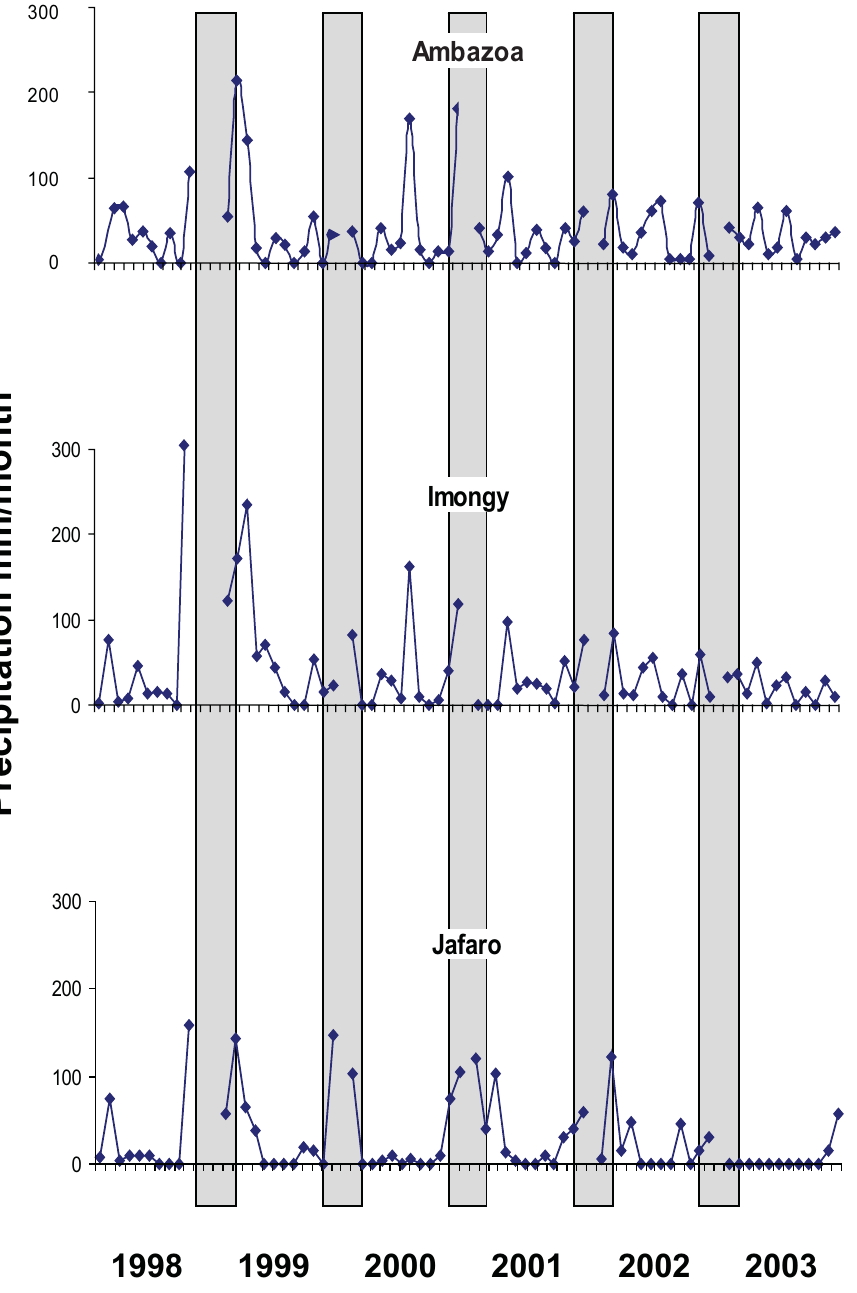
Figure 9. Precipitation (mm/month) during 1998–2003 from three areas in Androy (Area I: Jafaro, Area IV: Ambazoa and Imongy 25 u 19 9 S, 45 u 28 9 E). (SAP, European Union, Ambovombe, Jan. 2004, see [28]). The gray bars indicate the main cropping season.